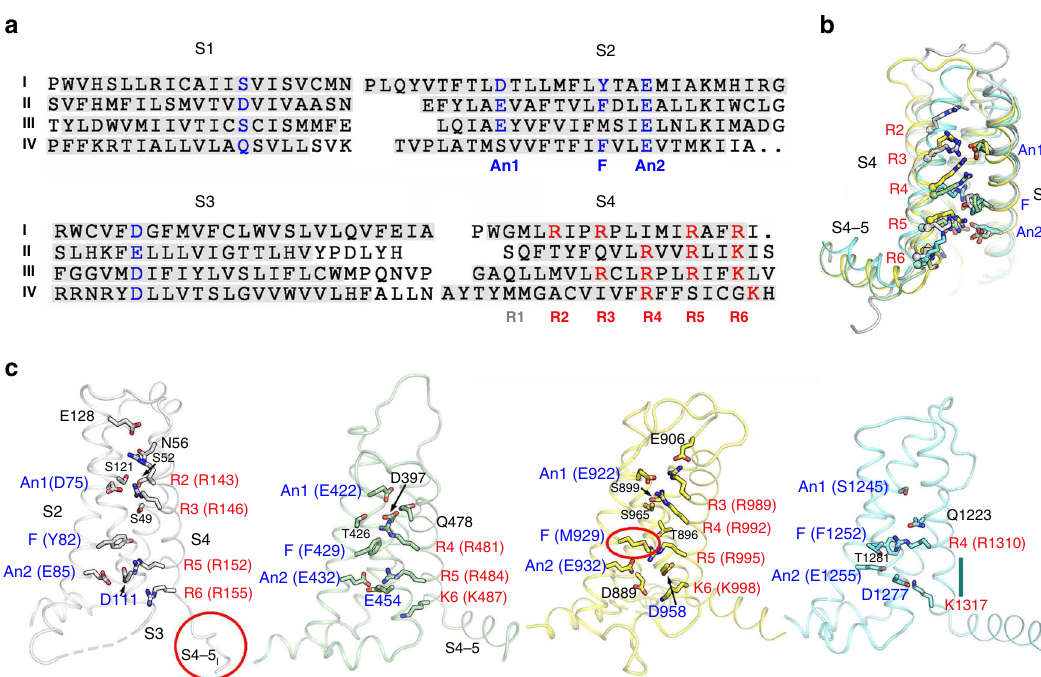
Fig. 4 Structural features of the VSDs of NALCN. a Structure-based sequence alignment of the four VSDs. The boundaries for the S1 to S4 segments are shaded gray. The gating charges (GCs) in the S4 helices are colored red. The residues that correspond to the charge transfer center (CTC) on S2 and S3 helices as well as the polar or acidic residues on S1 that coordinate GCs are highlighted in blue. b All four VSDs adopt up or depolarized state. The four VSDs are superimposed relative to CTC and An1 on S2. For visual clarity, the S1 segments are omitted. c Structural details of each VSD. The GCs, CTCs, and the polar or acidic residues participating in GC coordination are shown in sticks. The GCs are labeled in red. The S4-5 I loop and non-conserved aromatic residues in the CTC of repeat III are highlighted by red circles. The short 3 10 helix turn in repeat IV is indicated by a dark green